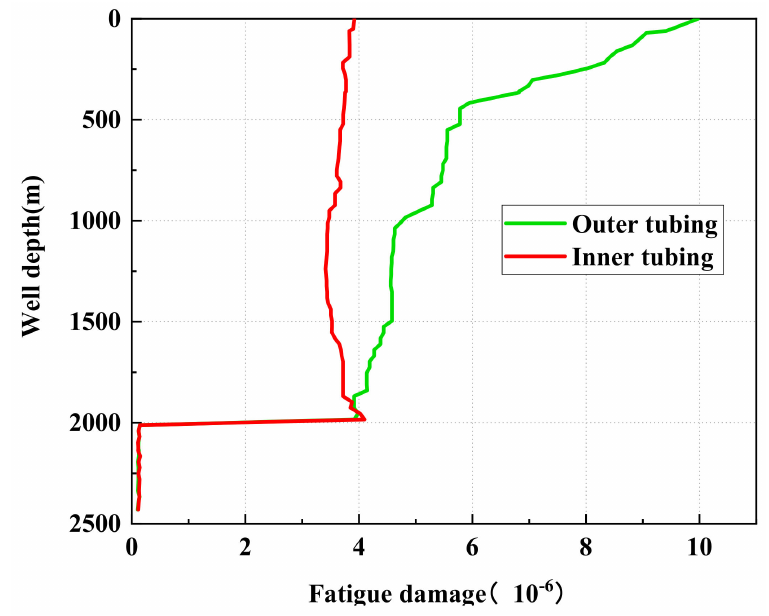
Figure 12. Fatigue damage distribution of the